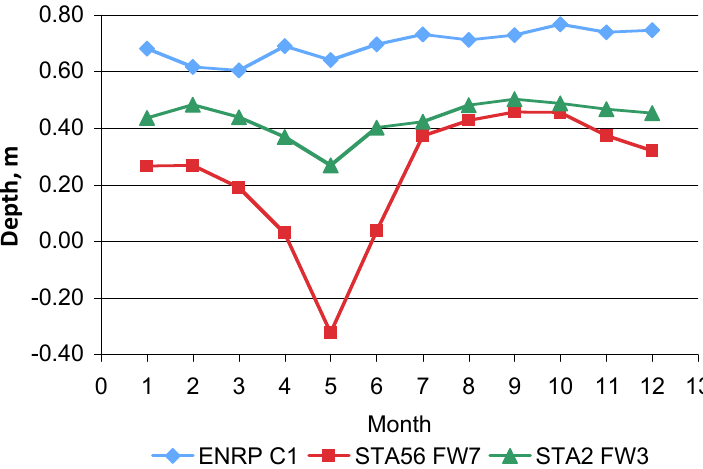
Figure 5. Average monthly water depths for three large P-control wetlands. ENRP C1 ( N = 5 years) contained emergent vegetation and was operated at nearly constant flow and depth. STA2 C1 ( N = 8 years) fosters submerged aquatic vegetation and, therefore, was kept hydrated in the dry season. STA56 FW7 ( N = 8 years) contains emergent vegetation, but was not kept hydrated in the dry season.